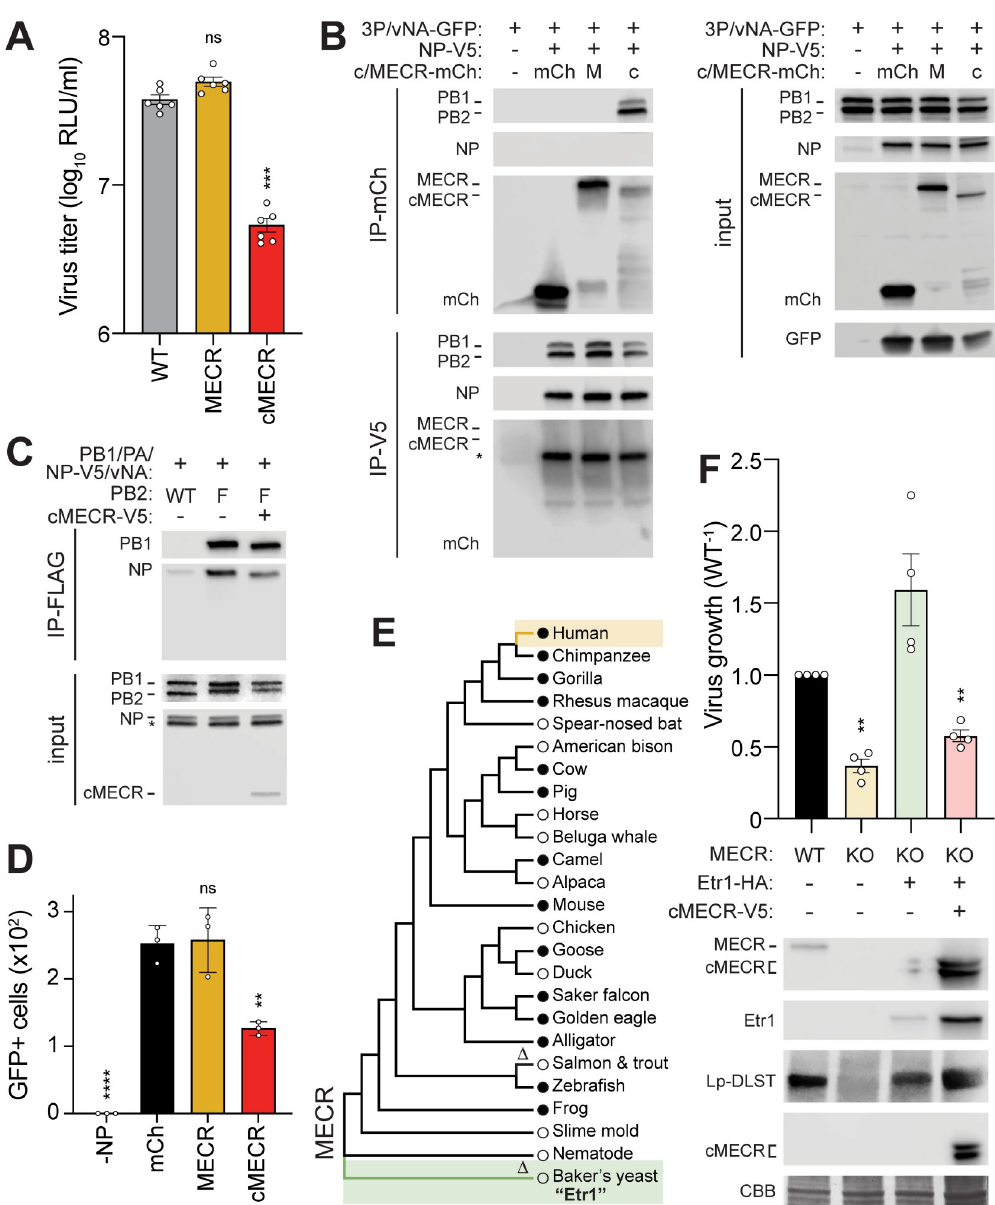
Fig 6. The antiviral activity of cMECR inhibits RNP assembly independent of MECR and mtFAS. (A) Replication of WSN NLuc was measured in WT or clonal A549 cells expressing MECR or cMECR. Protein expression from infected cells was analyzed by western blotting. Asterisk indicates a nonspecific band used as a loading control. Mean ± SD of n = 6. One- way ANOVA with post hoc Dunnett multiple comparisons test; ��� , P < 0.001; ns, not significant. (B-C) cMECR disrupts RNP assembly. (B) RNPs were assembled in 293T cells coexpressing mCh, MECR M77L-mCh, or cMECR-mCh. NP was omitted in the negative control ( − NP). Cells were lysed, divided in half, and immunoprecipitated for MECR (mCh) or NP (V5). Input or coprecipitated proteins were detected by western blot. � = NP detected from prior probing of the membrane before blotting for mCh. (C) RNP assembly monitored as in (B) except PB2 (FLAG) was targeted for immunoprecipitation with untagged PB2 as the negative control. (D) Polymerase activity assays with vNA-GFP were performed in the presence of mCh, MECR M77L-mCh, or cMECR-mCh. Fluorescence microscopy images taken at 24 h posttransfection and GFP- positive cells were enumerated by ImageJ. Mean ± SD of n = 3. Two-way ANOVA with post hoc Dunnett multiple comparisons test; ��� , P < 0.001; �� , P < 0.01; ns, not significant. (E) Phylogenetic maximum-likelihood analysis of MECR amino acid sequences. Δ , sequences lacking conserved cMECR start codon (Met77, human numbering). Circles indicate presence (filled circles) or absence (empty circles) of annotated cMECR transcripts. NCBI RefSeq IDs listed in S4 Table. (F) MECR KO cells were complemented with the MECR homolog from Saccharomyces cerevisiae Etr1 then transduced with cMECR. Cells were subsequently infected with WSN NLuc (MOI, 0.05; 24 h), and viral titers were measured in supernatants